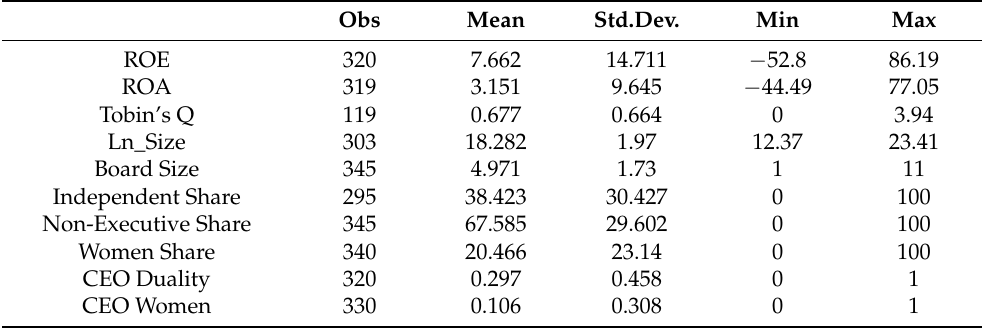
Table 2. Statistical Summary.